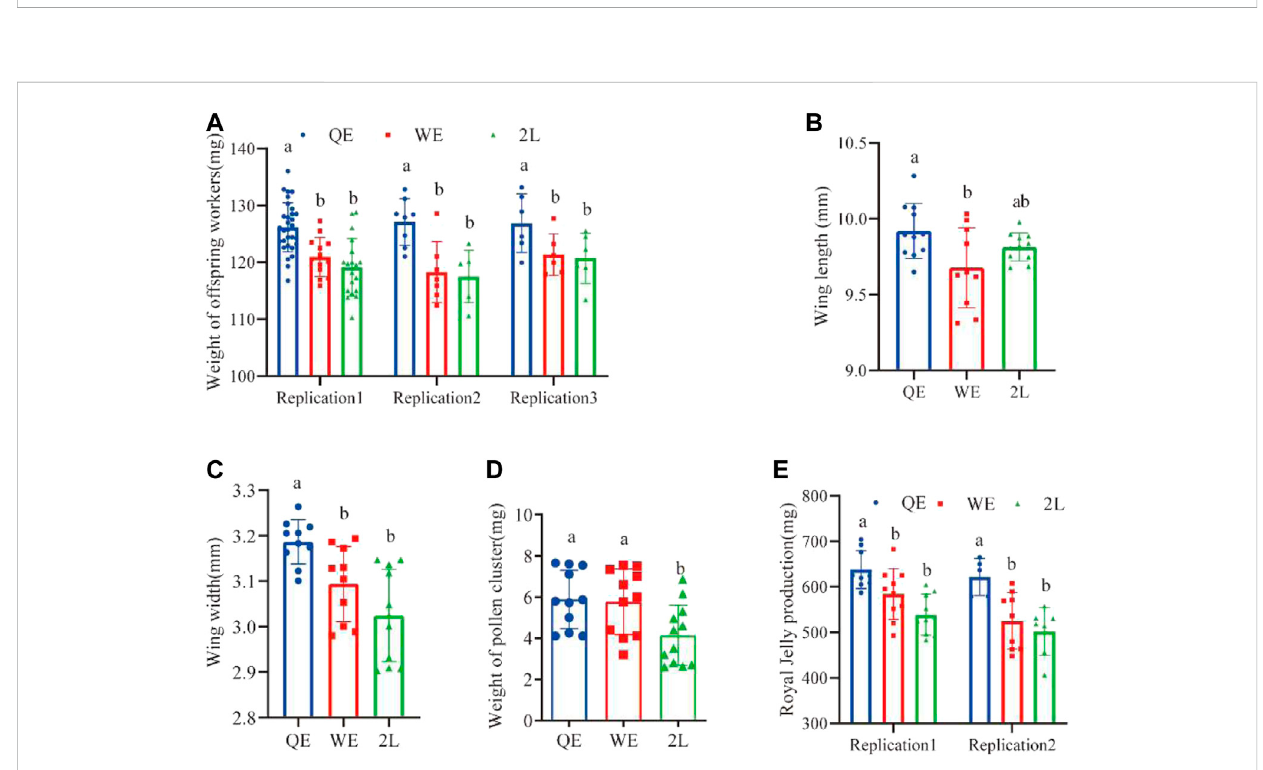
FIGURE 5 (A) Weight of newly emerged offspring worker bees, (B) wing length, (C) wing width, (D) weight of pollen on legs, and (E) royal jelly production (weight of newly emerged worker bees: replication 1, n = 31, 14, 19 for QE, WE, 2L, respectively; replication 2, n = 8, 7, 6 for QE, WE, 2L, respectively; replication 3, n = 6, 5, 6 for QE, WE, 2L. Wing length: n = 11, 10, 11 for QE, WE, 2L. Wing width: n = 10, 10, 11 for QE, WE, 2L, respectively. Weight of pollen cluster: n = 11, 11, 12 for QE, WE, 2L, respectively. Royal jelly production replication 1, n = 9, 10, 9 for QE, WE, 2L, respectively; replication 2, n = 5, 9, 7 for QE, WE, 2L,